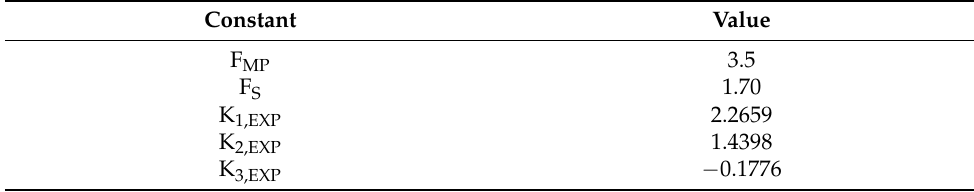
Table 4. Values of constants for estimating the capital cost of expander [28].